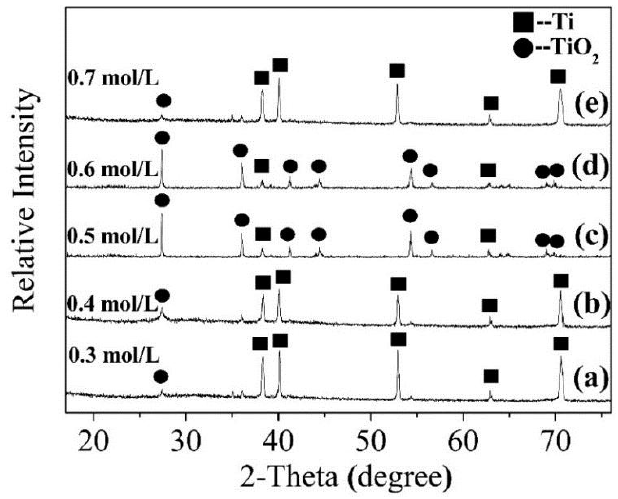
Figure 3. X-ray diffractometry (XRD) patterns of samples with different HCl concentration. ( a ) 0.3 mol/L; ( b ) 0.4 mol/L; ( c ) 0.5 mol/L; ( d ) 0.6 mol/L; ( e ) 0.7 mol/L.